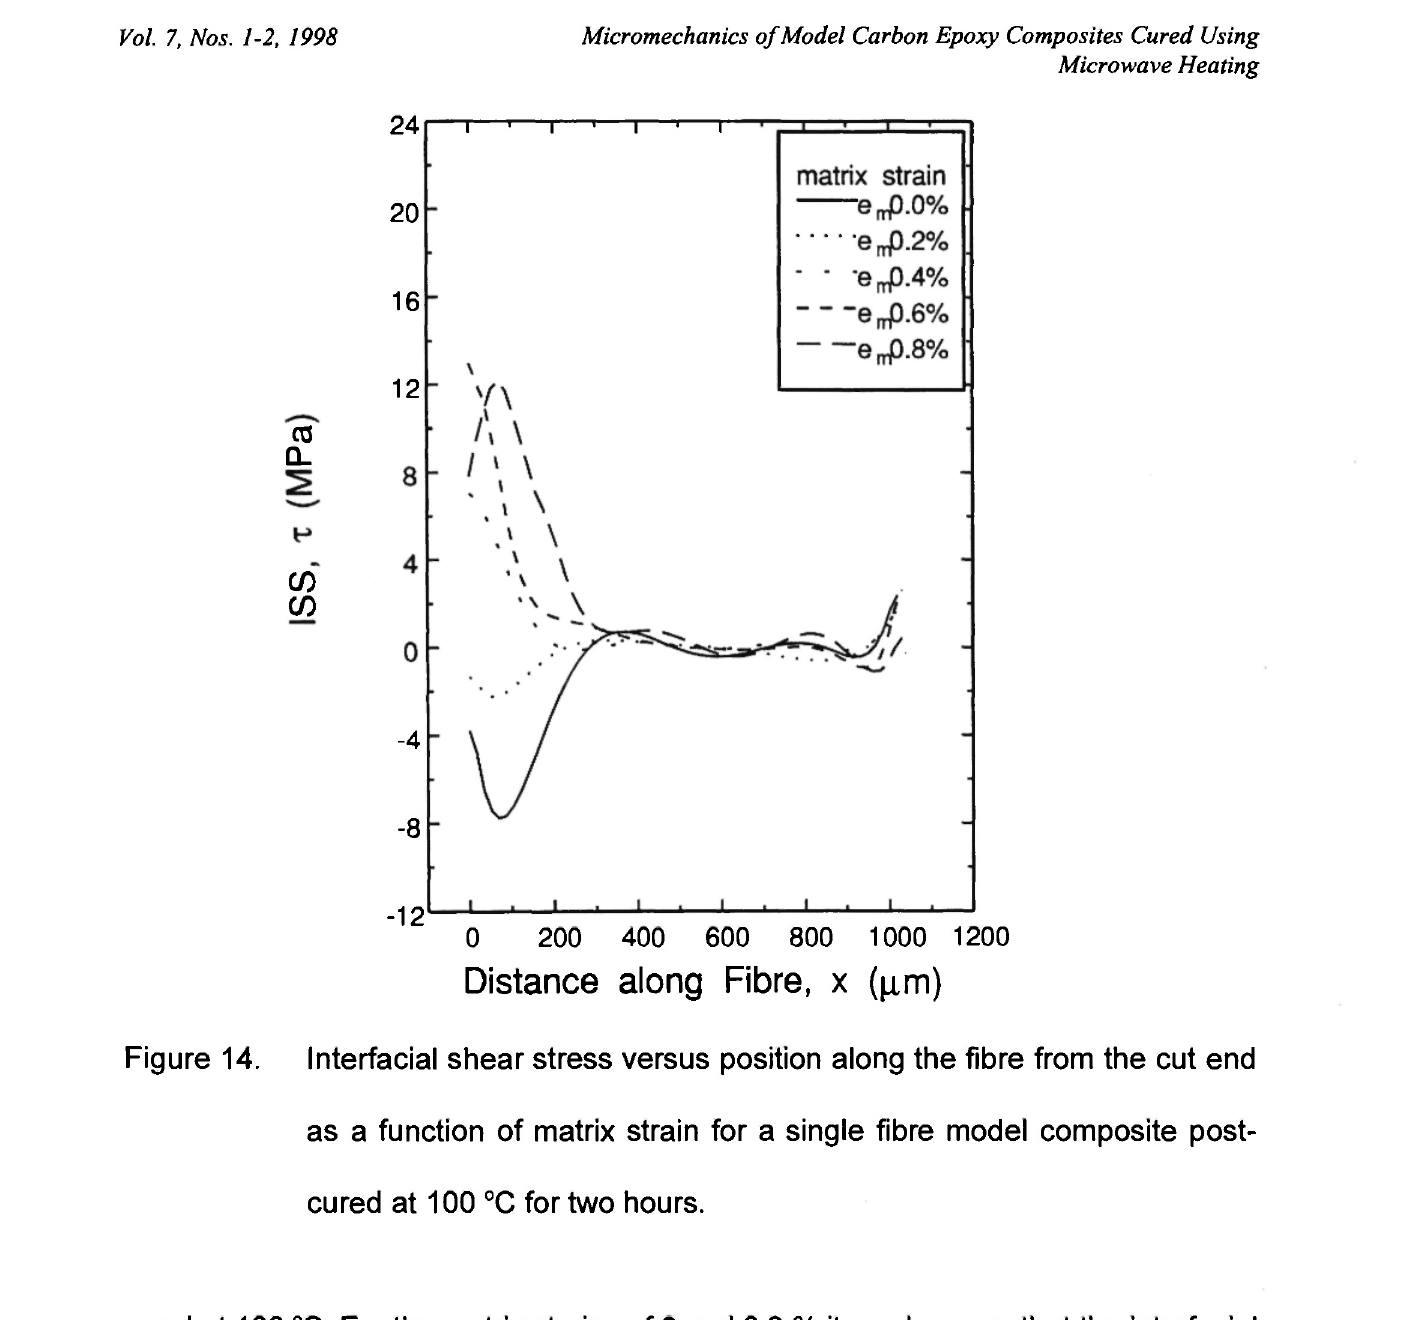
Figure 14. Interfacial shear stress versus position along the fibre from the cut end as a function of matrix strain for a single fibre model composite post- cured at 100 °C for two